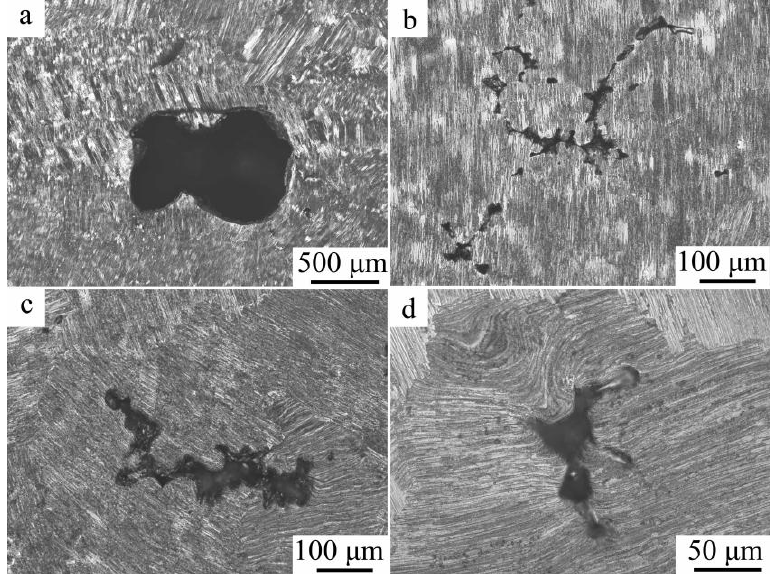
Figure 6. Micro-defects of test casting, ( a ) pore and ( b – d )